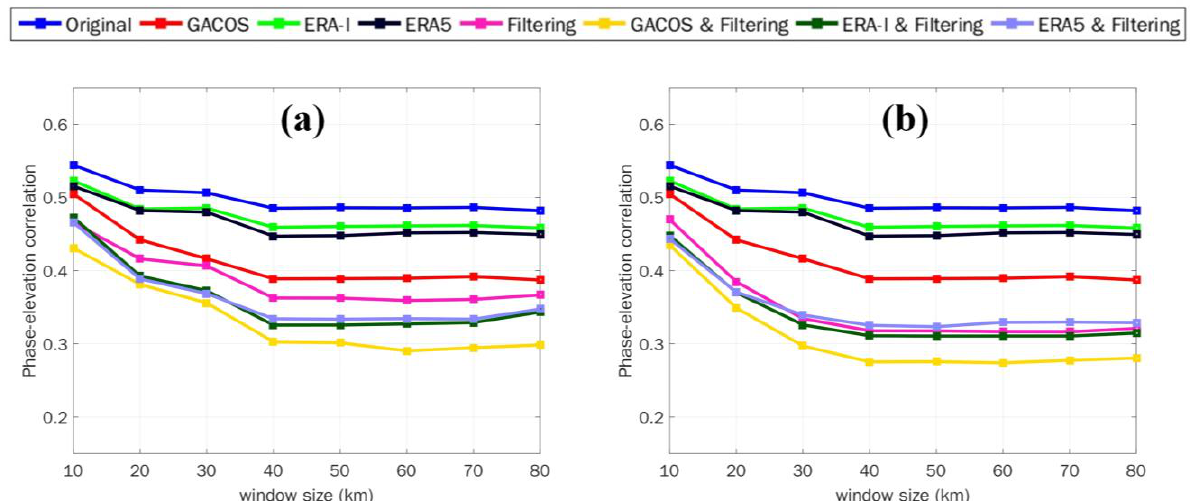
Figure 11. Phase-elevation rank correlation coefficient before and after tropospheric corrections, using the interferograms referenced to the acquisition date of 12 March 2017. ( a ) Results with the primary TOE retained. ( b ) Results after subtracting the primary TOE in the spatiotemporal filtering and the combined approaches.